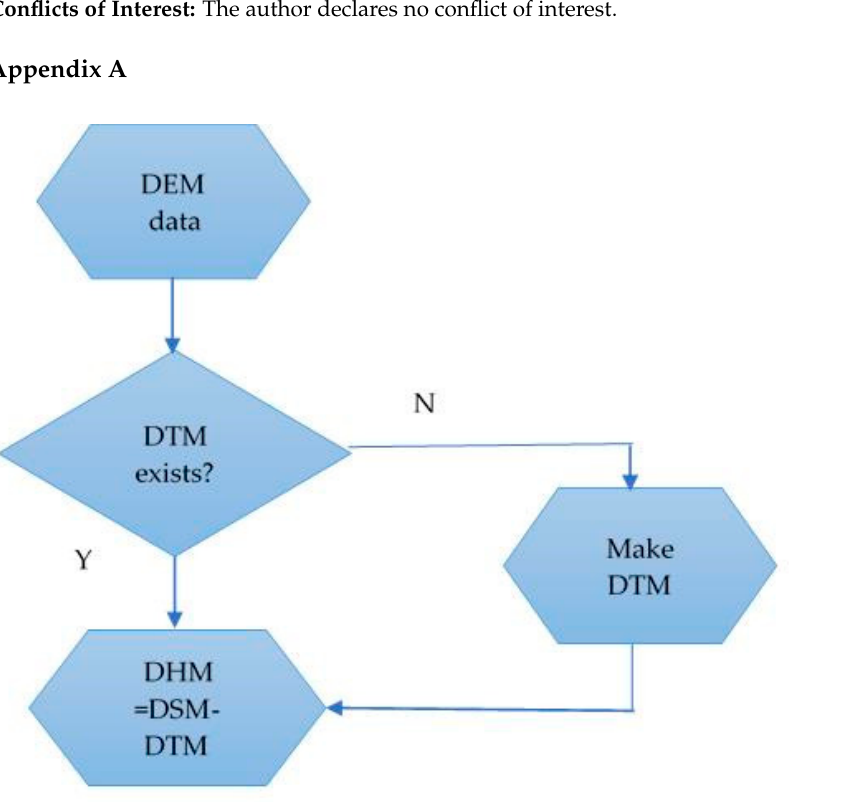
Figure A1. Flowchart of the generation of the DHM